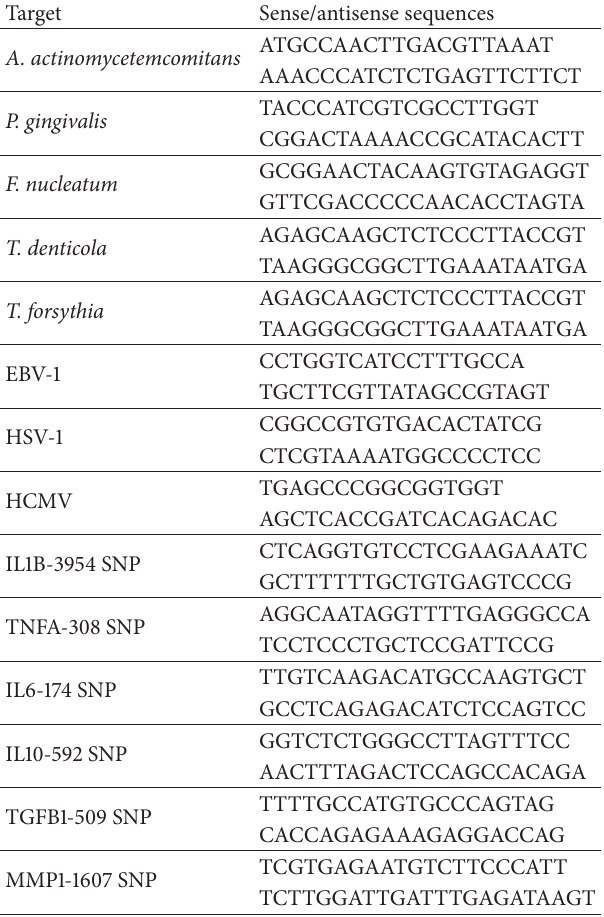
Table 2: Primer sequences from the genetic and microbiological